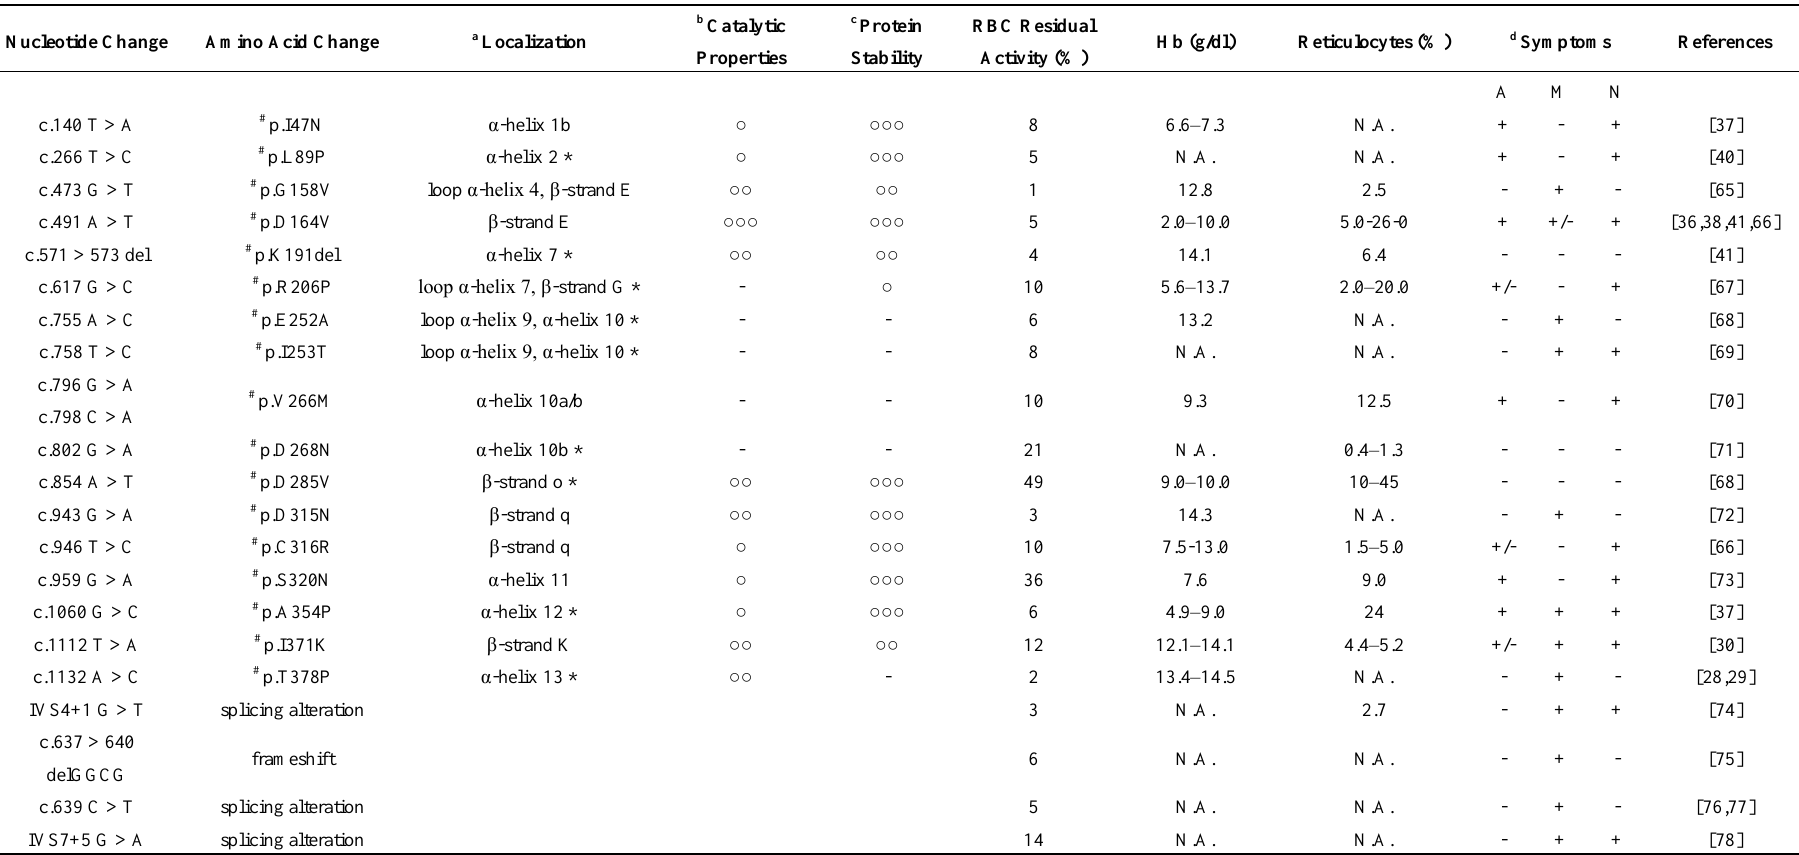
Table 1. hPGK1 mutations, their effects on enzyme molecular properties, and clinical features in patients with hPGK1 deficiency. Nucleotide